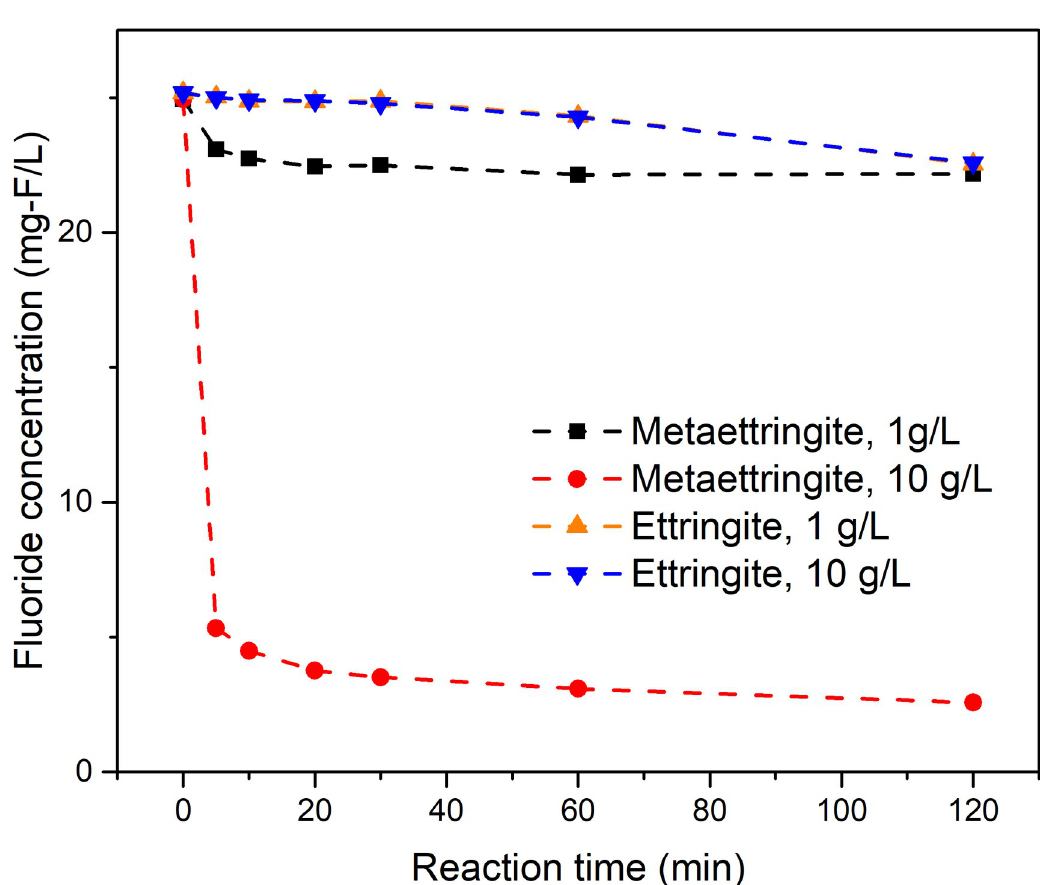
Fig 1. Comparison of time-dependent fluoride removal performance of ettringite and